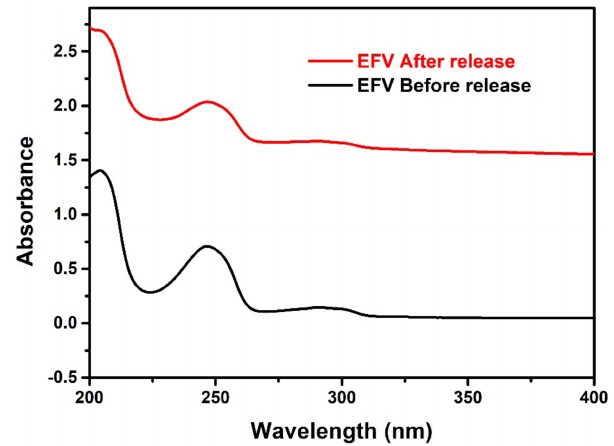
Figure 11. Efavirenz UV spectra before encapsulation and after release from EFV-LNC.